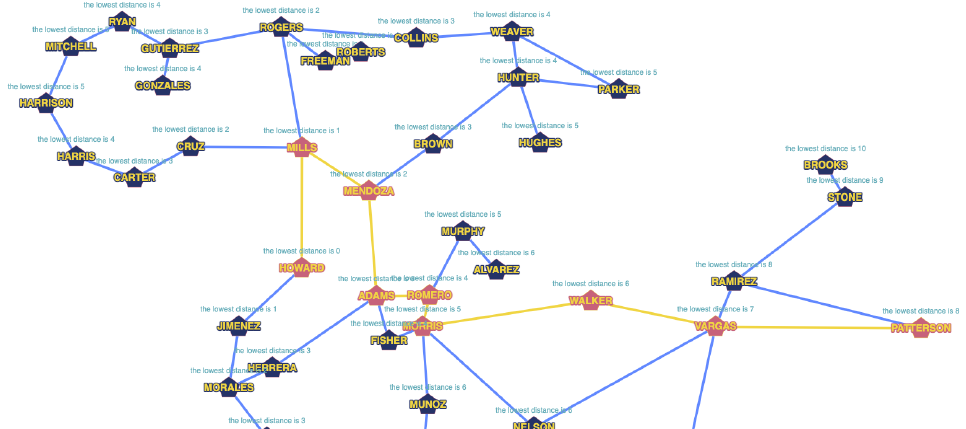
Figure 4. Detail of the result of the optimal path between nodes Howard and Patterson after eliminat- ing node Kelly by applying Dijkstra’s algorithm.